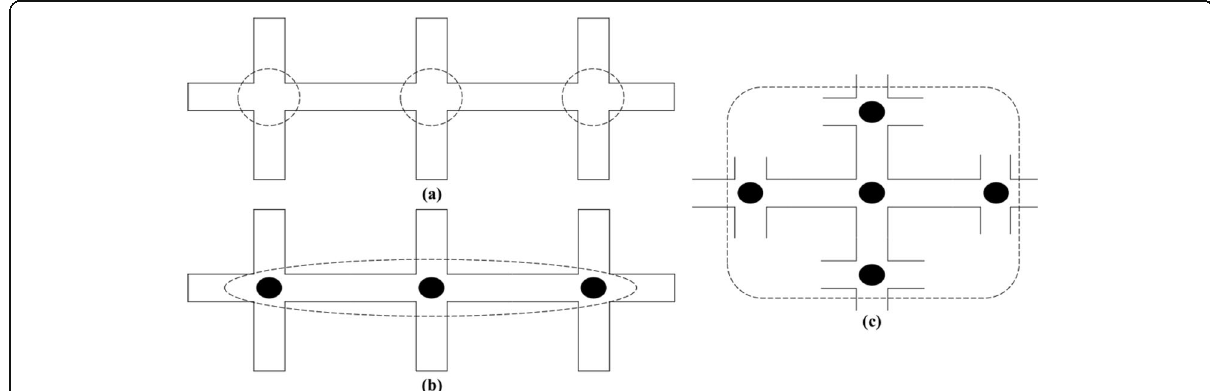
Fig. 3 Types of ITSCP networks: ( a ) isolated intersection, ( b ) arterial network, and ( c ) general network. Dashed lines represent the network extent for each problem. All intersections are four-legged